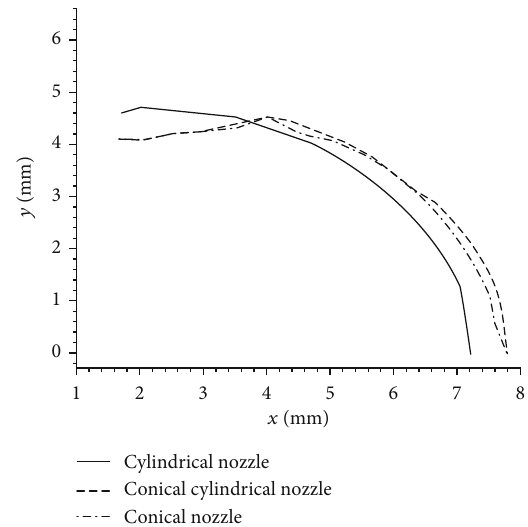
Figure 8: Change of volume fraction of drug with y